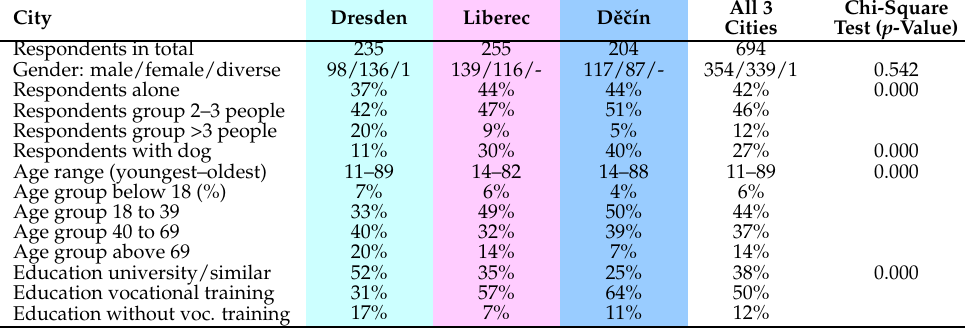
Table 1. Demographic characteristics of the